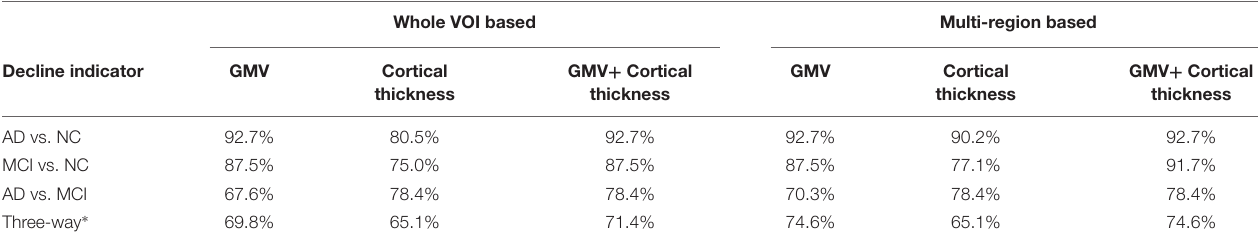
TABLE 3 | Predictive accuracies of the atrophy indicators. Whole VOI based Multi-region